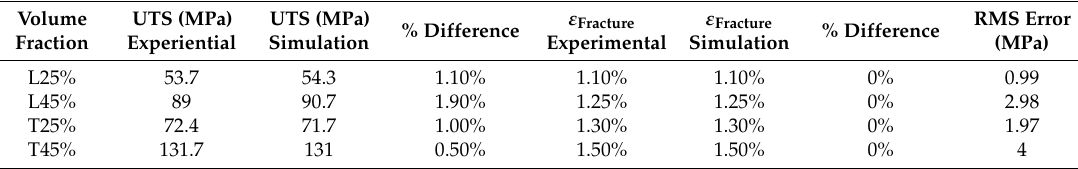
Table 2. Tensile Model Results. UTS: ultimate tensile strength, RMS: root mean square. Volume Fraction